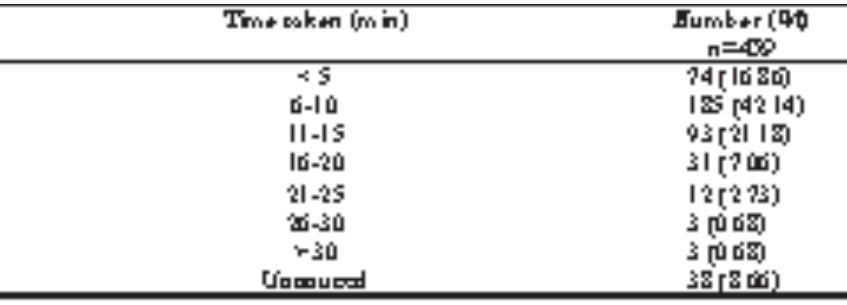
Table V : Time taken for